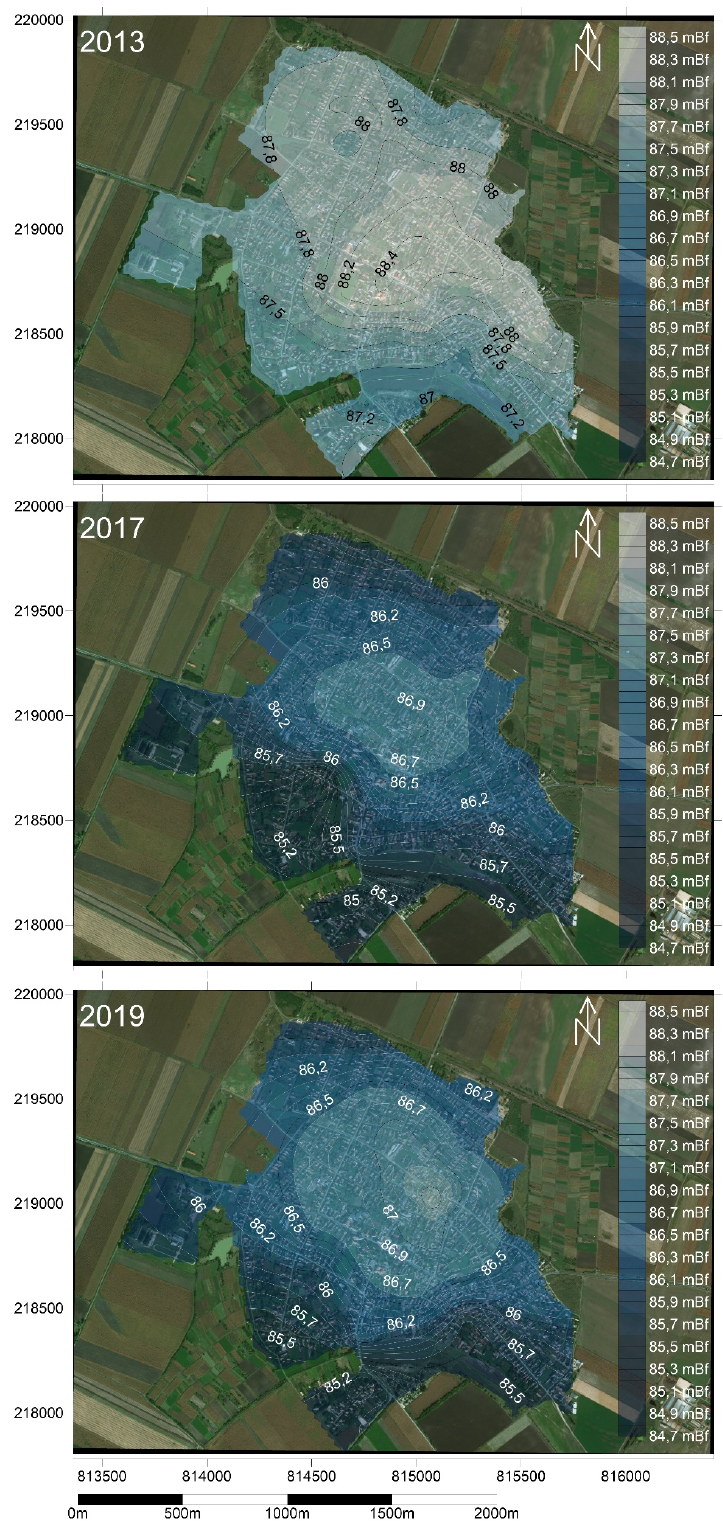
Figure 11. Groundwater table (a.s.l.) before (2013) and after (2017, 2019) the construction of the sewerage